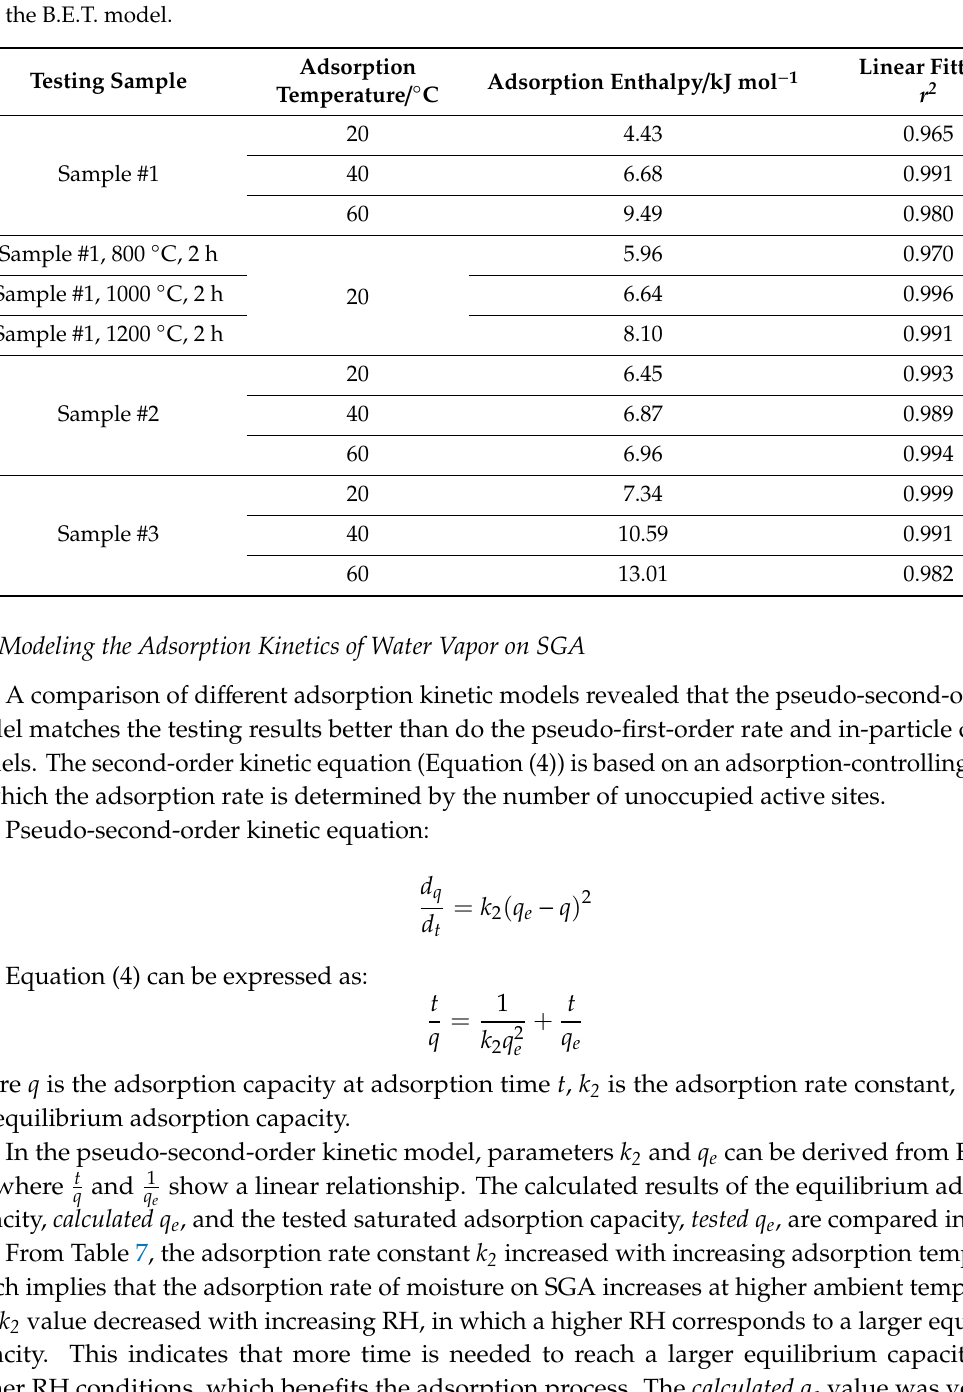
Table 6. The adsorption enthalpy of moisture on smelter grade alumina (SGA) derived from the B.E.T.